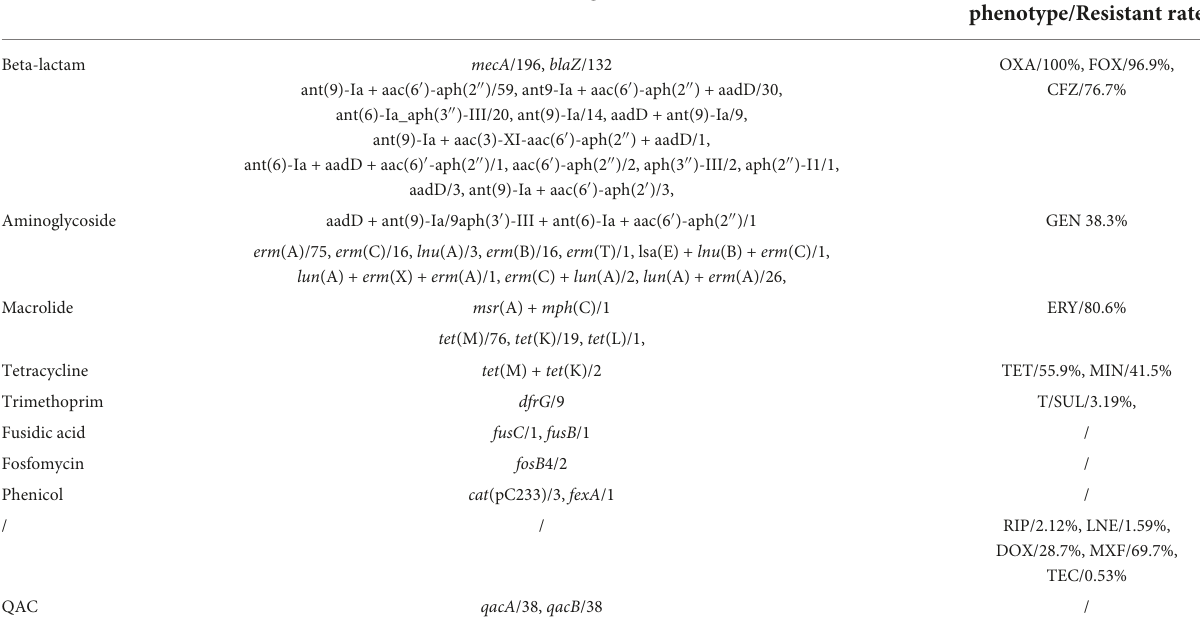
TABLE 3 Antibiotic resistant genes and resistant phenotype of methicillin-resistant Staphylococcus aureus (MRSA) isolates in this study. Antibiotics Antibiotic resistant genes/No. Resistant